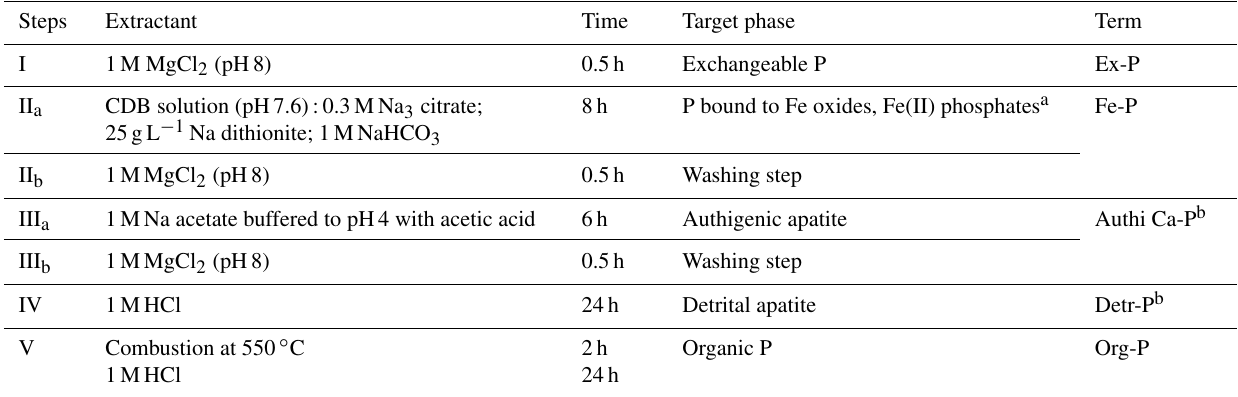
Table 2. Chemical solutions, targeted phases and terms of the sequential extraction (SEDEX; Ruttenberg, 1992) method, including the modifications by Slomp et al.